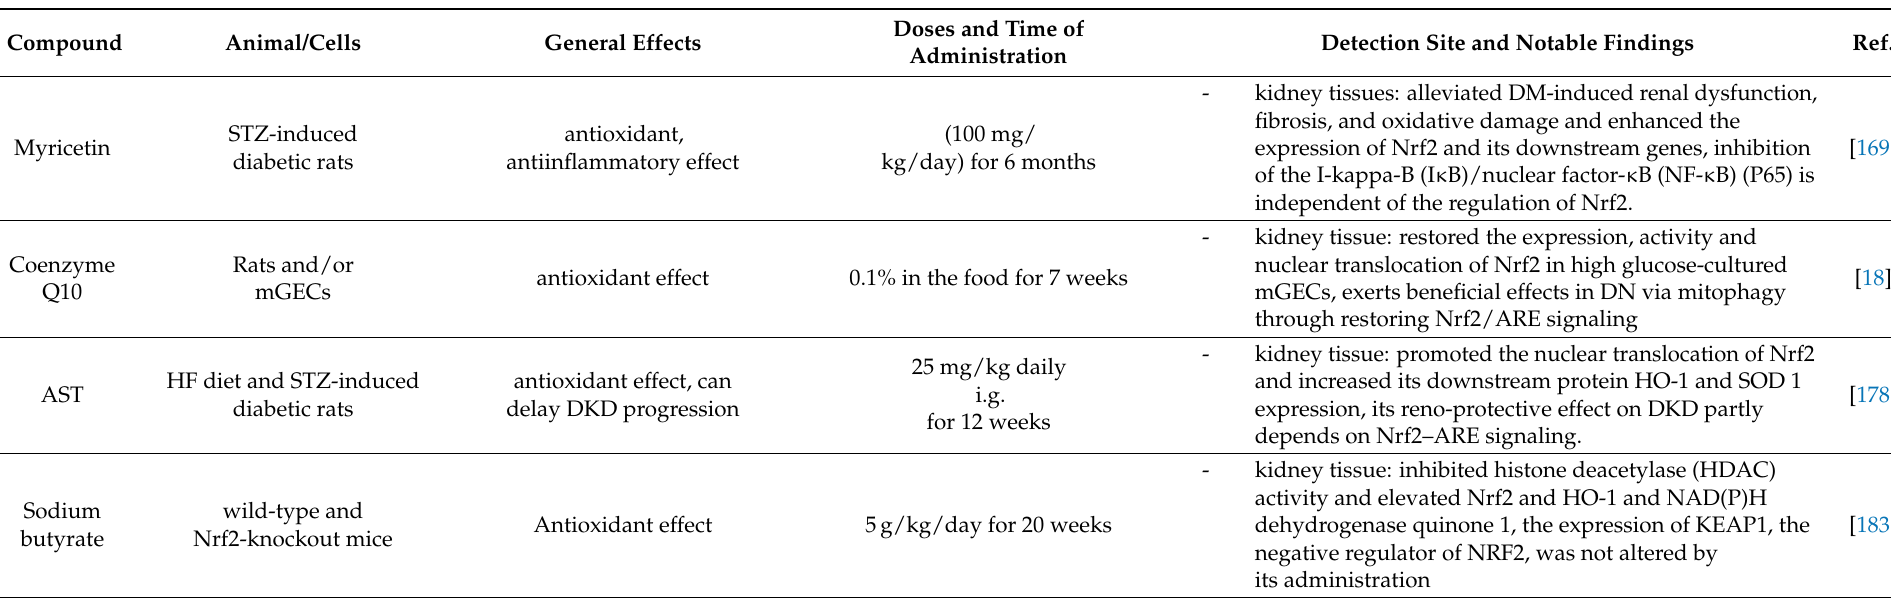
kidney tissue: restored the expression, activity and nuclear translocation of Nrf2 in high glucose-cultured mGECs, exerts beneficial effects in DN via mitophagy through restoring Nrf2/ARE signaling - kidney tissue: promoted the nuclear translocation of Nrf2 and increased its downstream protein HO-1 and SOD 1 expression, its reno-protective effect on DKD partly depends on Nrf2–ARE signaling. - kidney tissue: inhibited histone deacetylase (HDAC) activity and elevated Nrf2 and HO-1 and NAD(P)H dehydrogenase quinone 1, the expression of KEAP1, the negative regulator of NRF2, was not altered